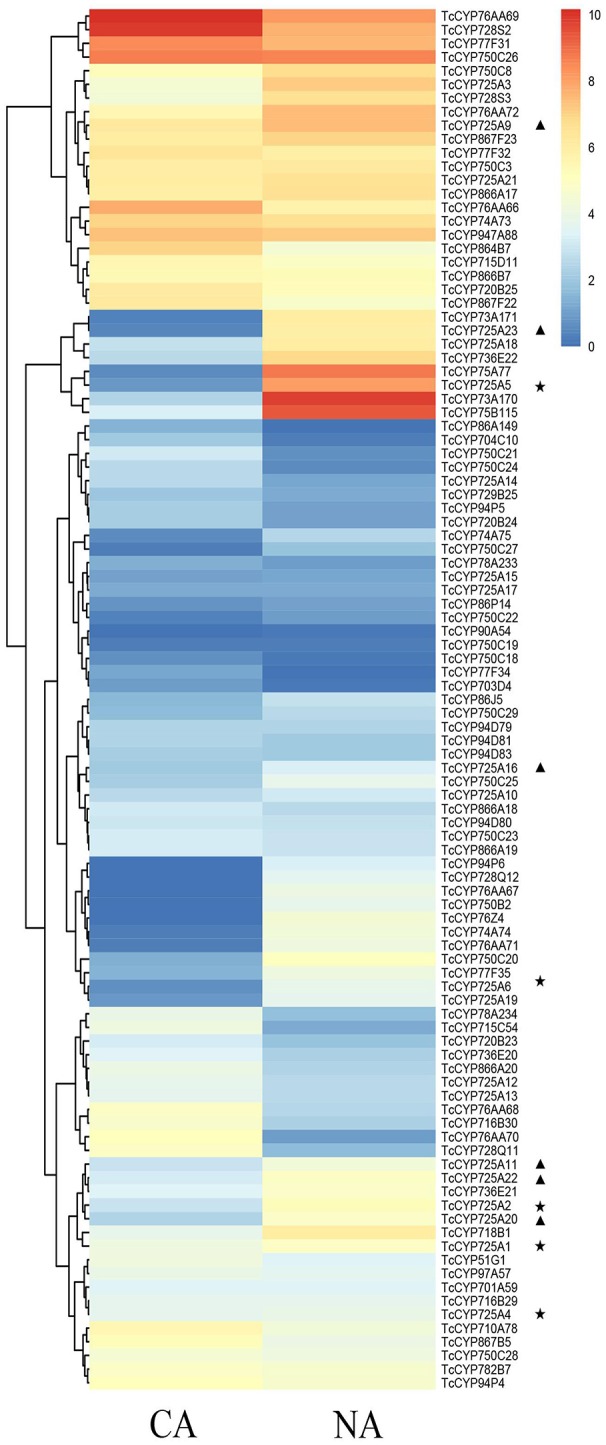
Expression pattern of T. chinensis CYP450s in CA and NA cell lines according to the analysis of RNA-Seq dataset. The color scale shows the expression quantity (red: high expression; blue: low expression). Heat map was created using HemI. Heatmap Illustrator v1.0. “⋆” indicates the known taxoid hydroxylase genes, and “▴” indicates the candidate genes.